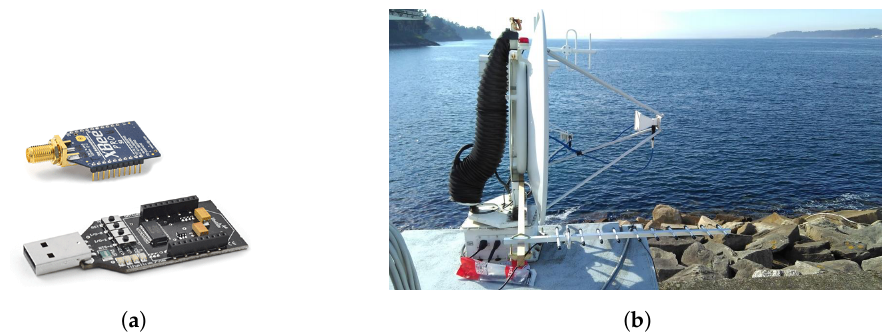
Figure 4. Ground station: ( a ) Waspmote Gateway XBee radio module; ( b ) Yagi antenna.